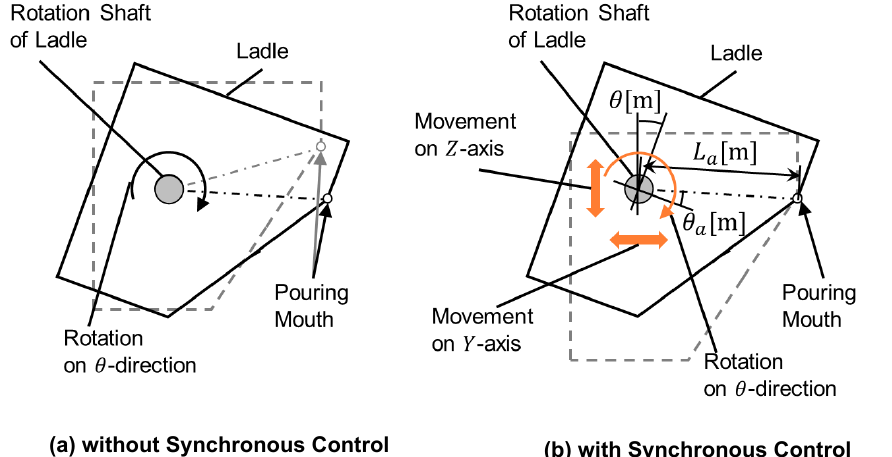
Figure 5. Motion of ladle with/without synchronous